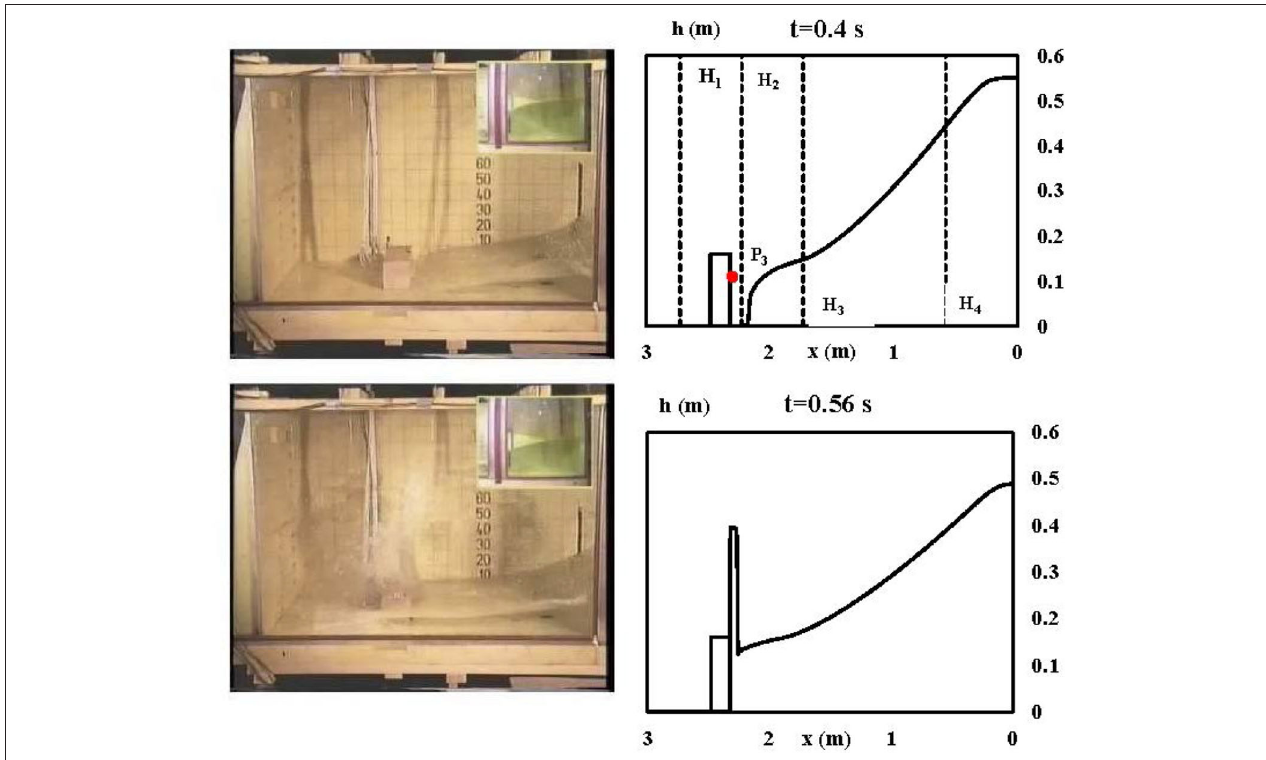
FIGURE 1 | Test case I. Experimental and numerical free surface profiles at t = 0.4 s and t = 0.56. Right : numerical free surface profiles. Top right panel shows gauges positioning along the centreline. Vertical dashed lines: positions of the height probes H 1 , H 2 , H 3 , and H 4 ; dot on the obstacle: position of the P 3 pressure probe. Left : experimental profiles of Kleefsman et al.